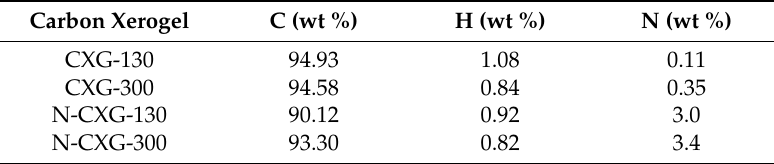
Table 2. Weight percentage of C, N, and H determined by elemental analysis. Carbon